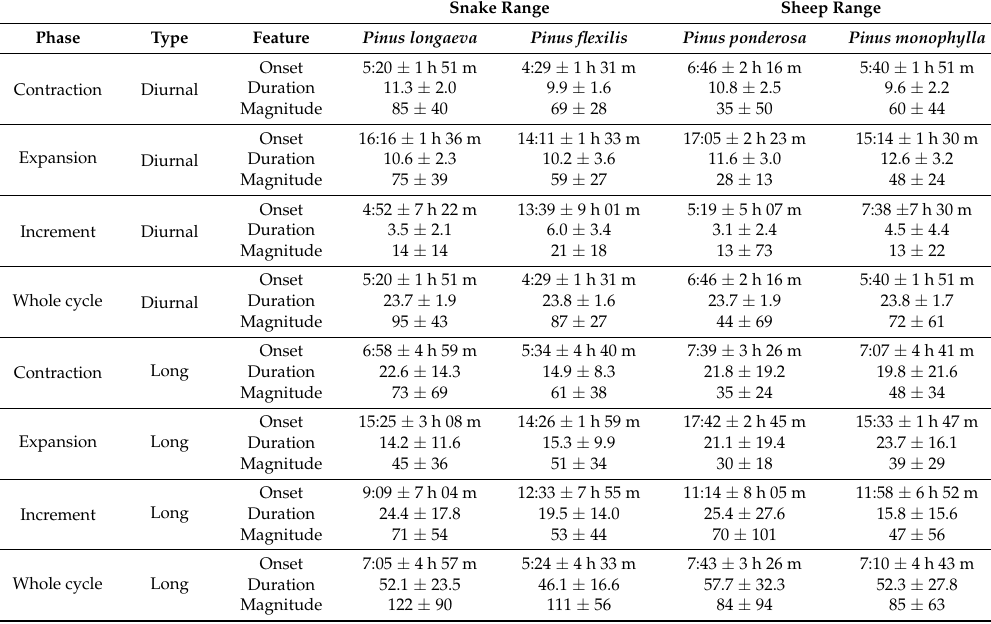
Table 2. Summary statistics (mean ± 1 standard deviation) by species and phase at our study sites for diurnal and long cycles of stem variation occurring from June to September (see text for details). Onset = hour of day; Duration = hours; Magnitude = µ